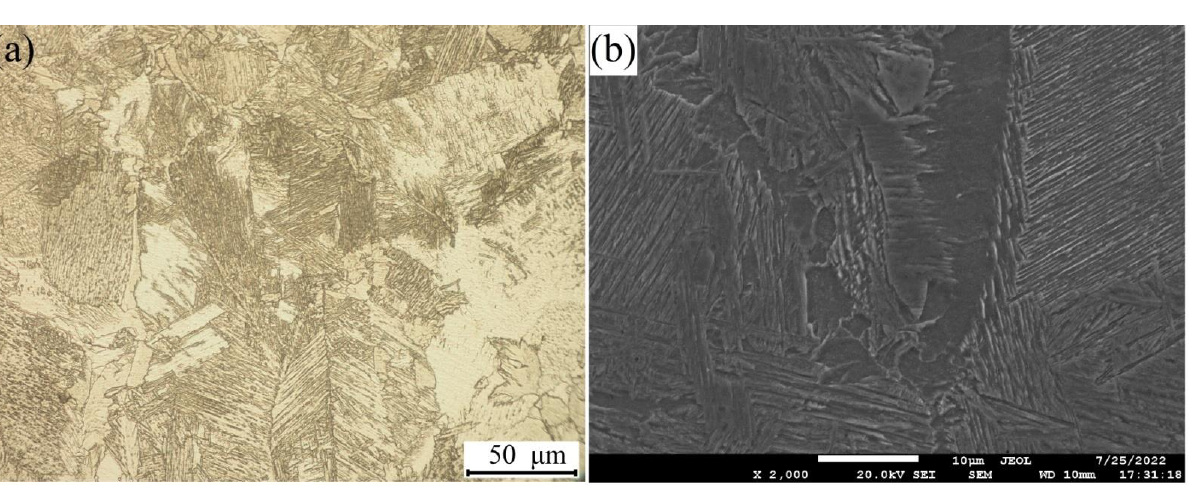
Figure 7. The microstructure of the FZ: ( a ) OM; ( b ) SEM.